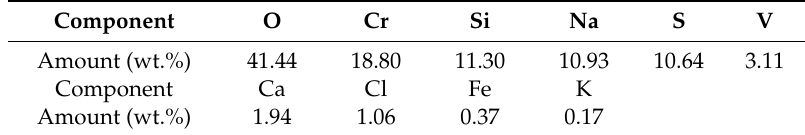
Table 1. Composition of the vanadium–chromium reducing residue (wt.%).